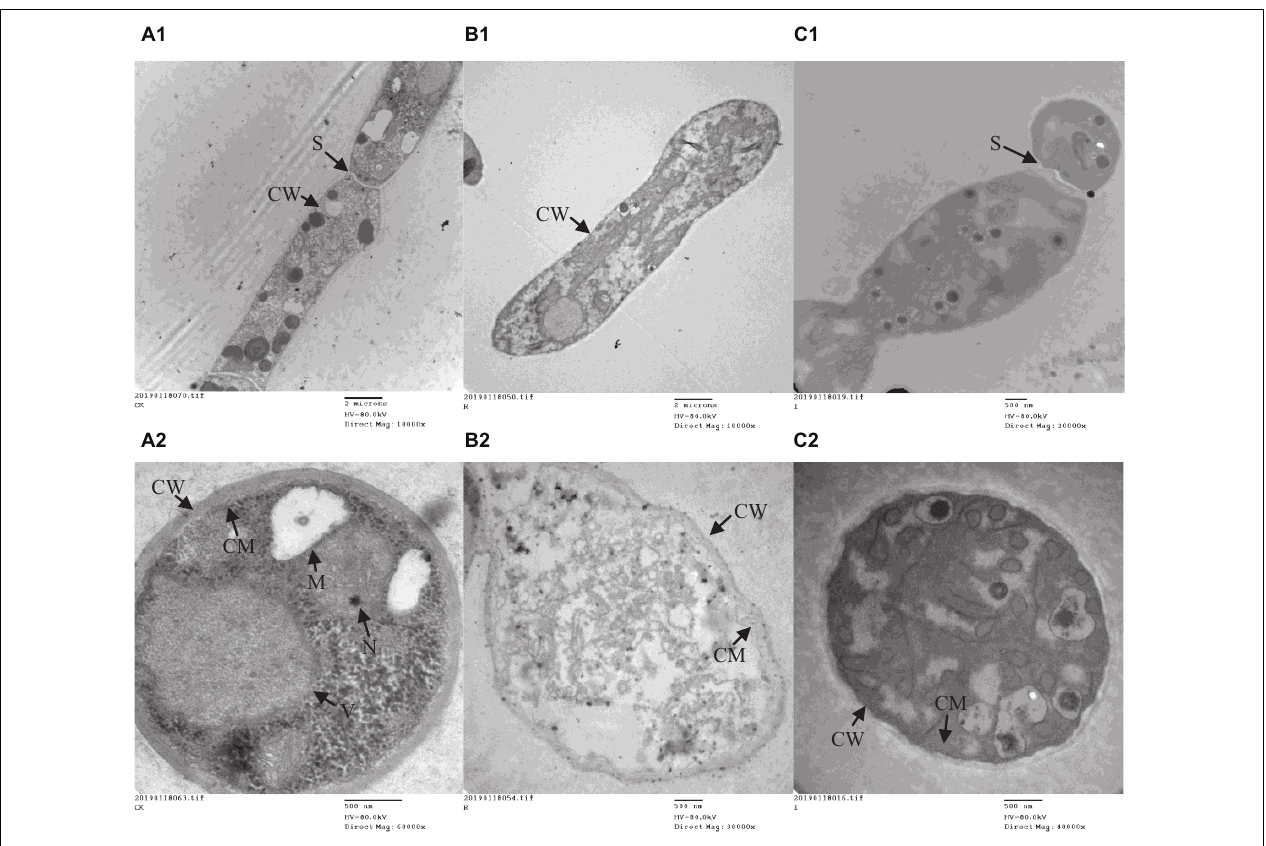
FIGURE 3 | The ultrastructure of G. graminis var. tritici hyphae cells treated with fengycin and iturin A observed using transmission electron microscopy (TEM). (A 1 ,A 2 ) The untreated Ggt hyphae; (B 1 ,B 2 ) the Ggt hyphae treated with fengycin, showing cytoplasmic digestion, disintegration of organelles, and formation of a large number of blank areas; (C 1 ,C 2 ) the Ggt hyphae treated with iturin A, showing cell wall digestion, cell membrane degradation, and cytoplasmic pyknosis. (A 1 ,B 1 ,C 1 ) longitudinal sections of Ggt hyphae; (A 2 ,B 2 ,C 2 ) transverse sections of Ggt hyphae. CW, cell wall; CM, cell membrane; M, mitochondria; N, nucleus; S, septum; V,